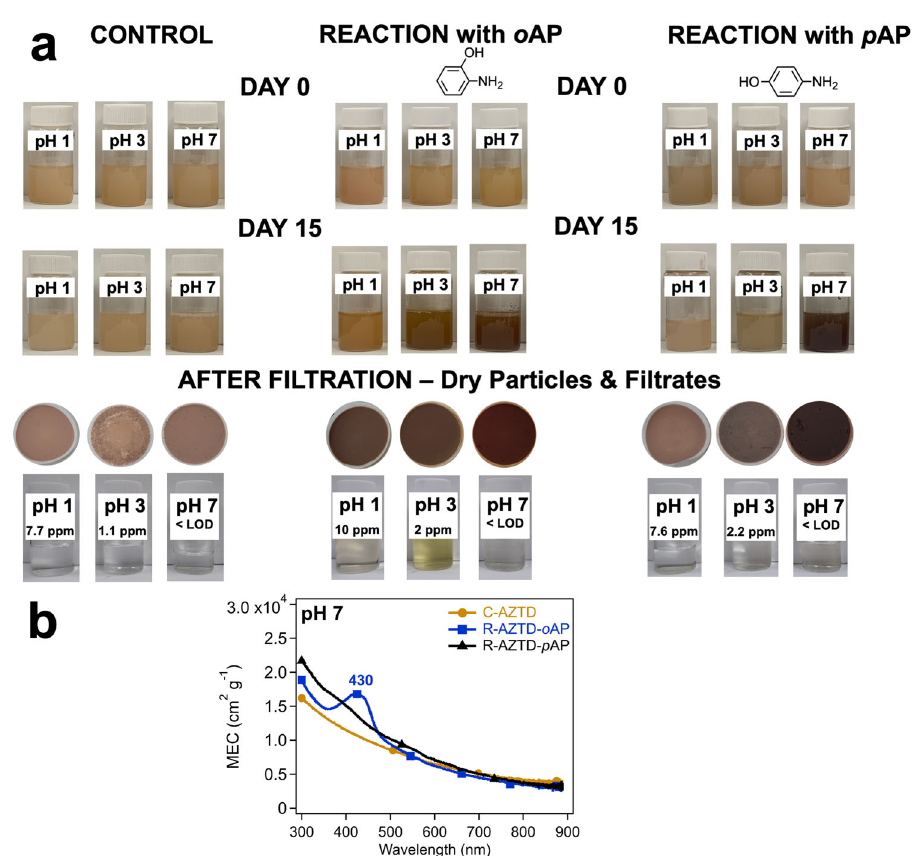
Fig. 5 Reactivity of aminophenols with AZTD under simulated dust aging. a Digital photographs of control (left), reaction with ortho -aminophenol ( o AP, middle), and para -aminophenol ( p AP, right) vials containing AZTD as a function of pH and time (0 and 15 d) of simulated atmospheric aging time. Similar photos for days 2 and 7 are shown in Supplementary Figure 8. These samples were used for electron microscopy and elemental mapping. The pH values shown in the label of each vial refers to the starting pH of the slurry. At the end of day 15, the slurries were fi ltered, and the corresponding fi lters and fi ltrates are shown below each vial. The concentration of DFe in the fi ltrates after 15 d in the fi ltrates of are listed as well. The limit of detection was determined to be 0.06 ppm (mg L − 1 ). b MEC spectra as a function of wavelength for diluted AZTD slurries at pH 7 for the control (no organics added) and reacted particles with o AP and p AP for 15 d. The absorbance and MAC spectra of fi ltrates at pH 3 are shown in Supplementary Figure